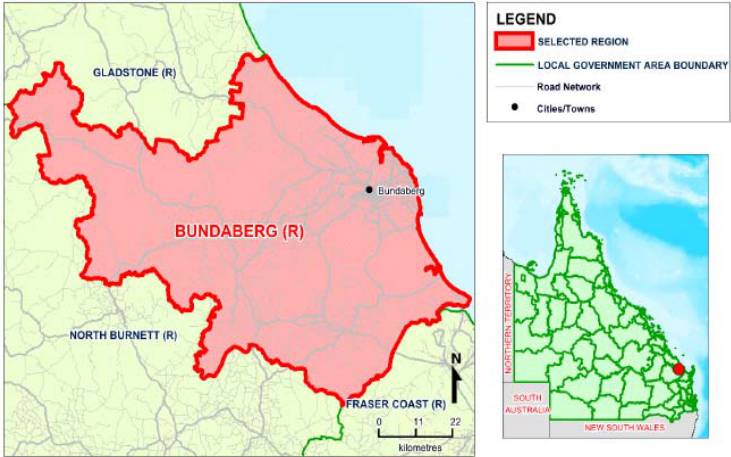
Figure 1. Map of Bundaberg Regional Council [45].